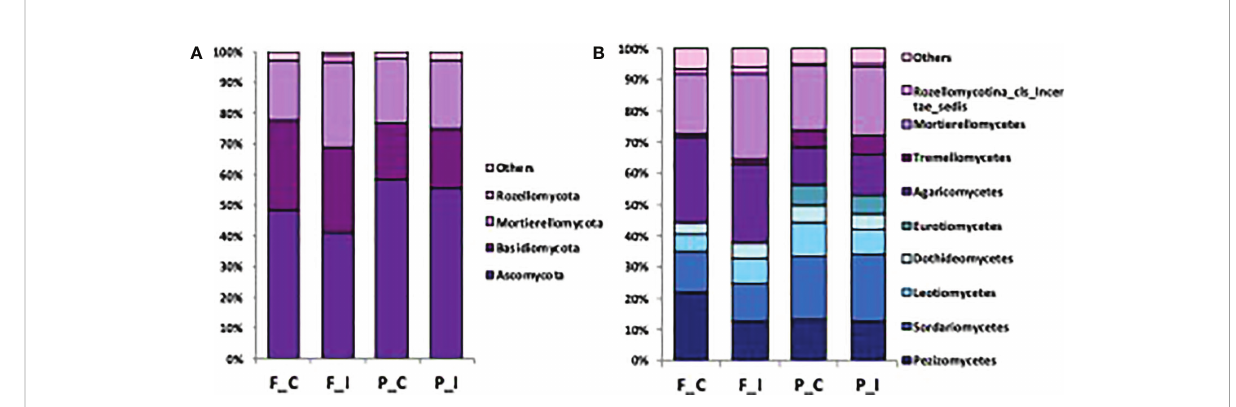
FIGURE 3 Barplots showing the fungal community composition at the phylum (A) and class (B) level in soil for each site (Fresnes-sur-Escaut, F; Pierrelaye, P) and treatment (control, C; inoculated,